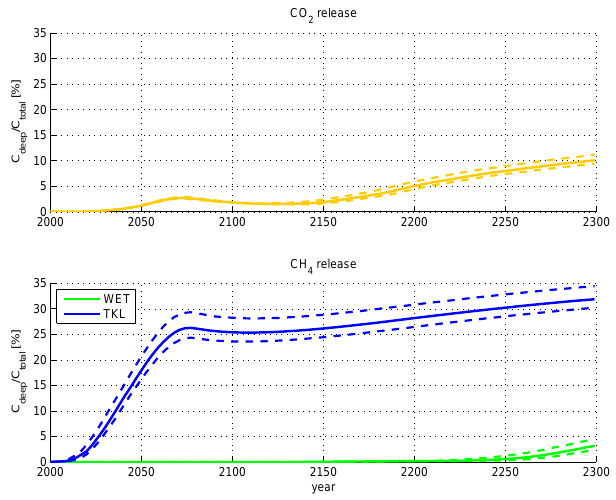
Figure 4. Contribution of deep permafrost carbon deposits to to- tal carbon fluxes under aerobic (upper panel) and anaerobic (lower panel) conditions. Shown is the contribution of cumulated CO 2 and CH 4 fluxes from deep deposits (3 to 15m) to total circumarctic car- bon release (0 to 15m) under strong warming (RCP8.5). Solid lines represent median values, dashed lines 68% ranges. The contribu- tion of deep deposits to wetland-affected CH 4 release (green) and to thermokarst-affected CH 4 release (blue) is shown